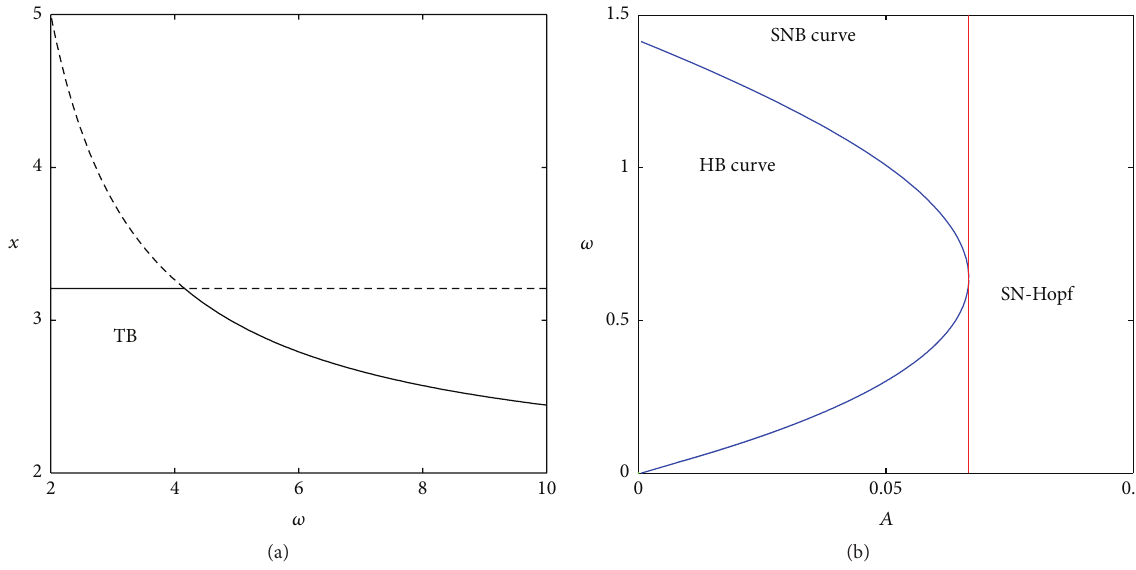
Figure 4: Transcritical and saddle-node-Hopf bifurcations of system (7). (a) A transcritical bifurcation occurs when equilibria 𝐸 2 and 𝐸 1 collide at 𝜔 ≈ 4.157 , where 𝐴 = 0.05 , 𝑏 = 0.4 , 𝑐 = 1 , 𝑑 = 0.6 , ℎ = 2.0 , 𝛽 = 2.6 , 𝛼 = 1.8 , and 𝑚 = 0.3 , where the black dash curve denotes stable equilibrium and the black solid curve denotes unstable equilibrium. (b) The double parameter bifurcation in the plane (𝐴, 𝜔) and other parameters take the same values as in (a), where the blue solid curve is Hopf bifurcation curve (HB) and the red solid line is saddle-node bifurcation curve. The intersection of HB curve and SNB curve is saddle-node-Hopf bifurcation (SN-Hopf).